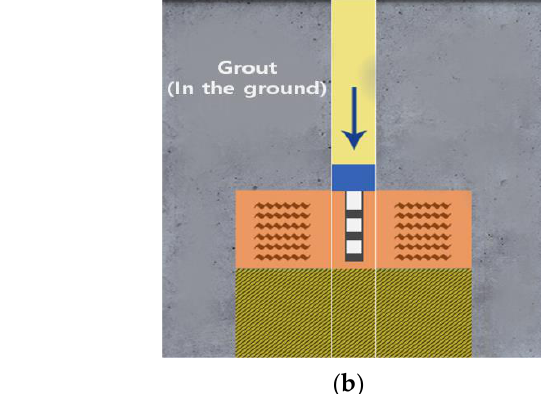
Figure 1. Types of grouting methods: ( a ) Colloidal silica grouting; ( b ) Space grouting rocket system [23].